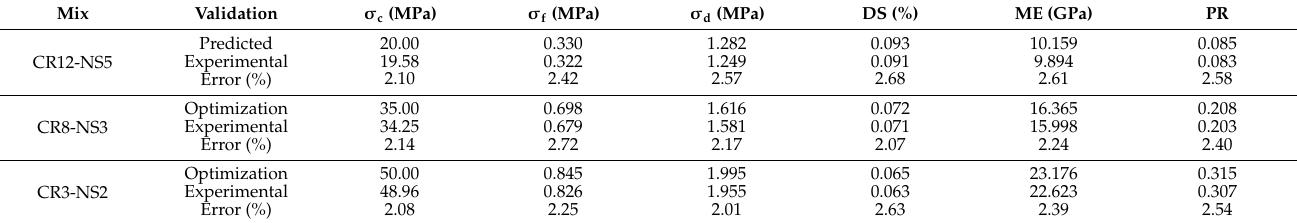
Table 11. NS-CRM models verification.